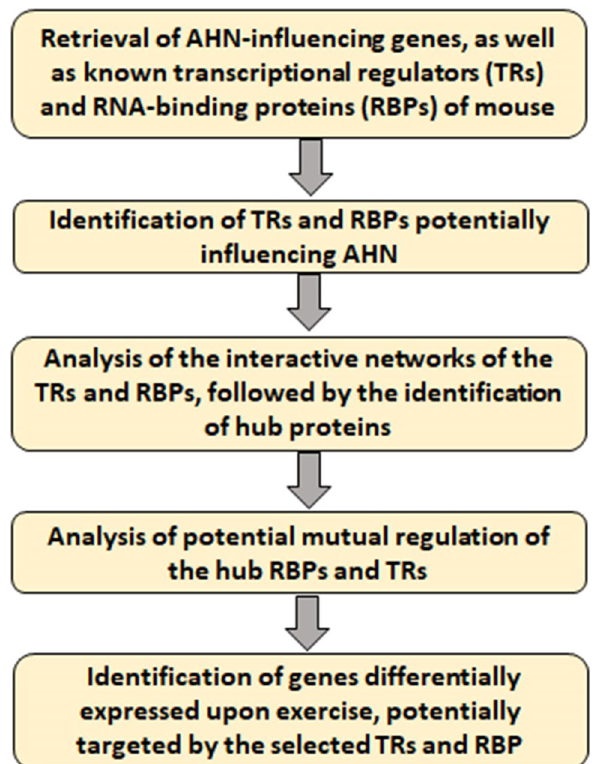
Fig. 1 Work-flow of the pre- sent study. AHN-related genes were retrieved from Mamma- lian Adult Neurogenesis Gene Ontology (MANGO) database, followed by identification